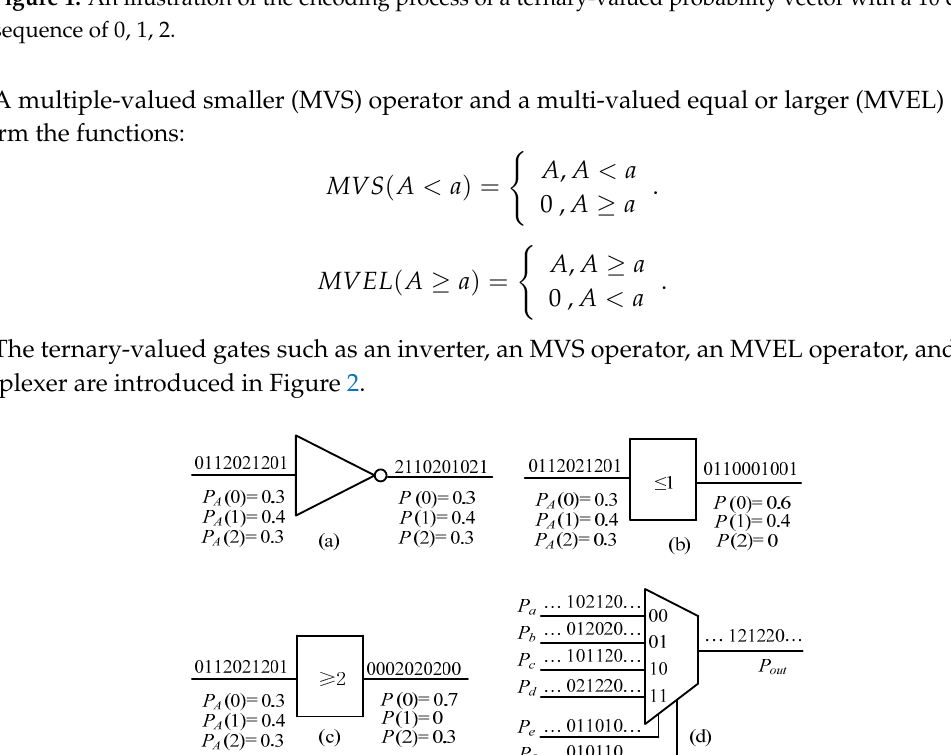
Figure 1. An illustration of the encoding process of a ternary-valued probability vector with a 10 digit sequence of 0, 1, 2.